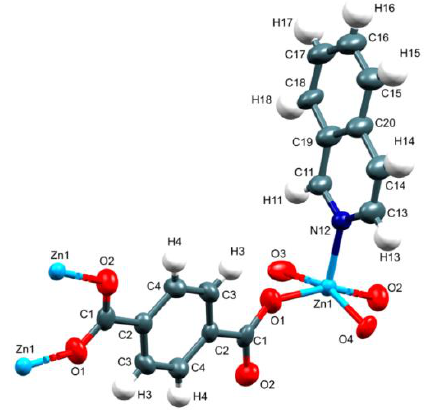
Figure 1. Asymmetric unit of 1 .